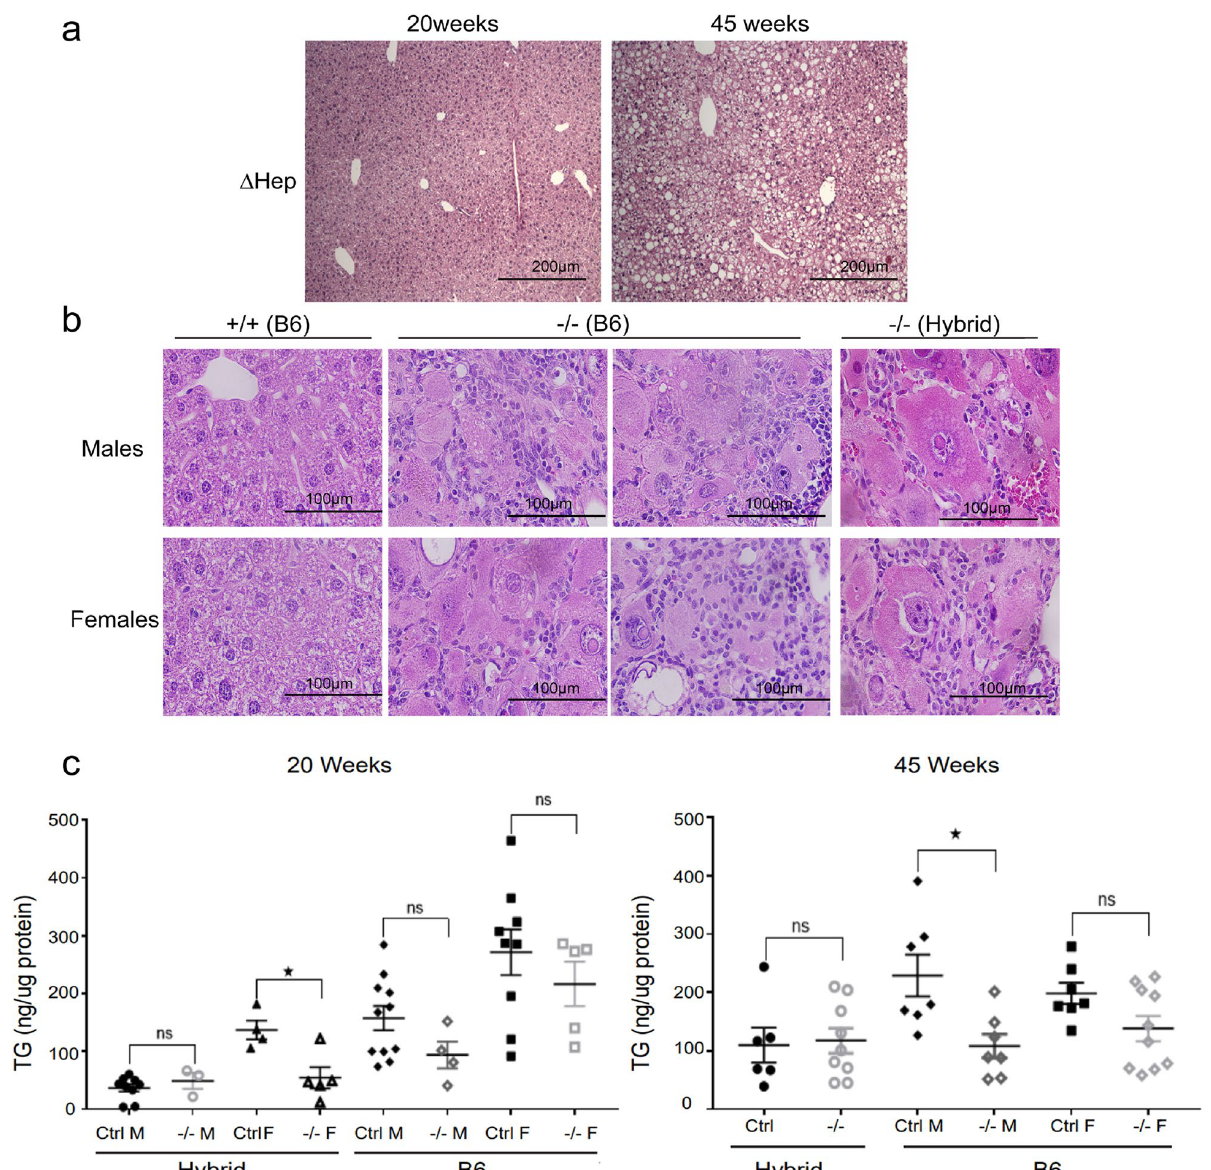
Figure 3. Global and hepatocyte-specific deletion of Atp7b have different impact on lipid metabolism. ( a ) The representative H&E staining of liver section illustrates the development of steatosis in Atp7b ΔHep -B6 animals (ΔHep), in agreement with the previous reports ( 21 ); ( b ) the lack of liver steatosis in Atp7b − / − -B6 and Atp7b -/– hybrid mice (males and females). ( c ) Triglyceride concentrations in the livers of Atp7b− / − hybrid (Hybrid) and Atp7b -/– B6 (B6) mice. The one-way ANOVA was used for statistical analysis * p value ≤ 0.05 was considered statistically significant, p > 0.05 is not statistically significant, (ns). “Ctrl”—control group—included wild-type and heterozygous animals on the corresponding genetic